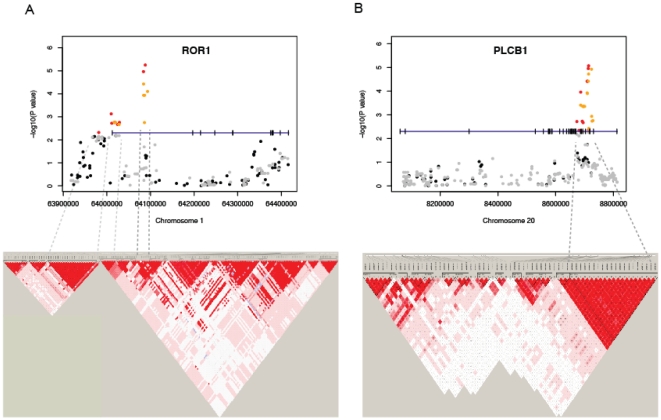
P value plots, genomic structures and LD maps of (A) the ROR1 gene and (B) the PLCB1 gene.The –log10 of the association P value of each SNP was plotted according to its chromosomal position. The gene structure was drawn at P = 5×10-3 with the vertical ticks indicating exons, and the SNPs above this threshold were colored red (experimental) or orange (imputed) and those below it black (experimental) or gray (imputed). The promoter region was attached to the ROR1 genebody to show the SNPs near the transcription start site. The LD maps based on D' were drawn by Haploview using the genotype data of all cases.